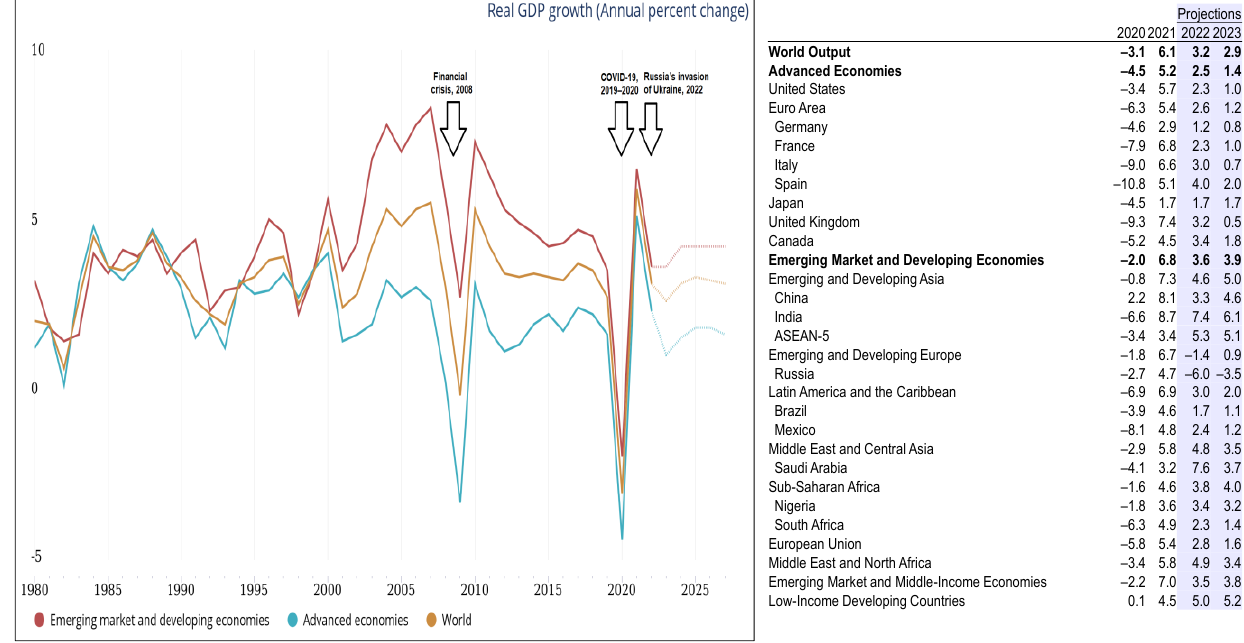
Figure 1. Capturing the global crisis in macrofigures. Source: Based on [20].